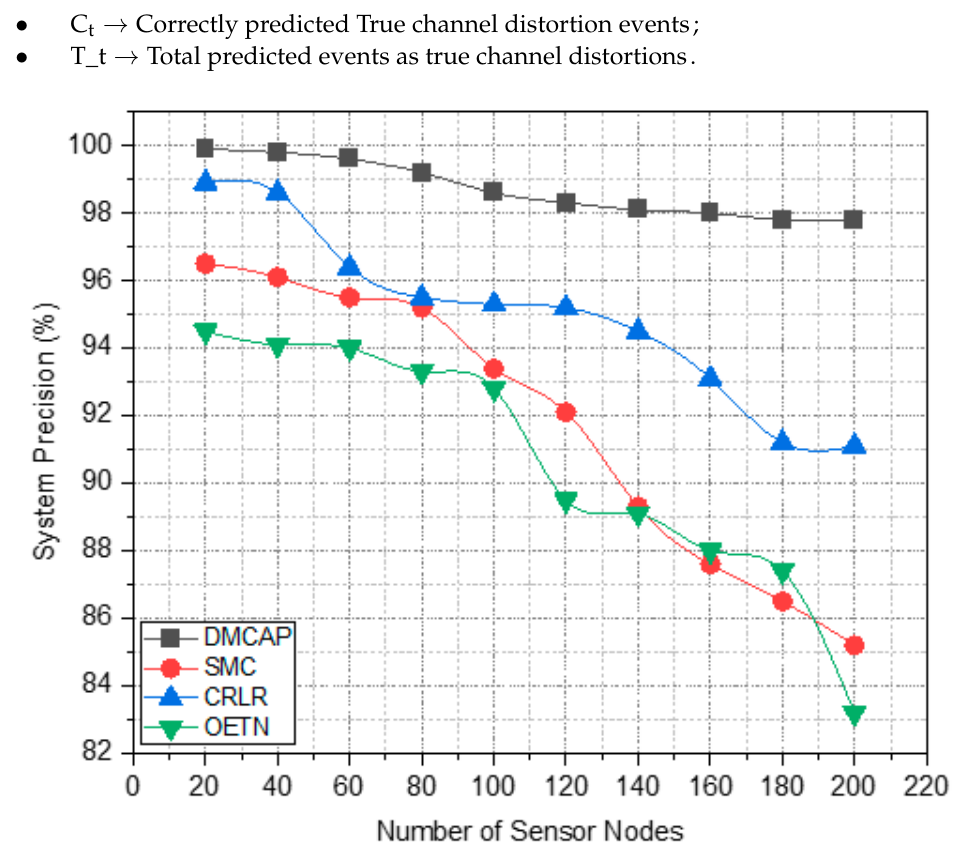
Figure 7. System precision rate.